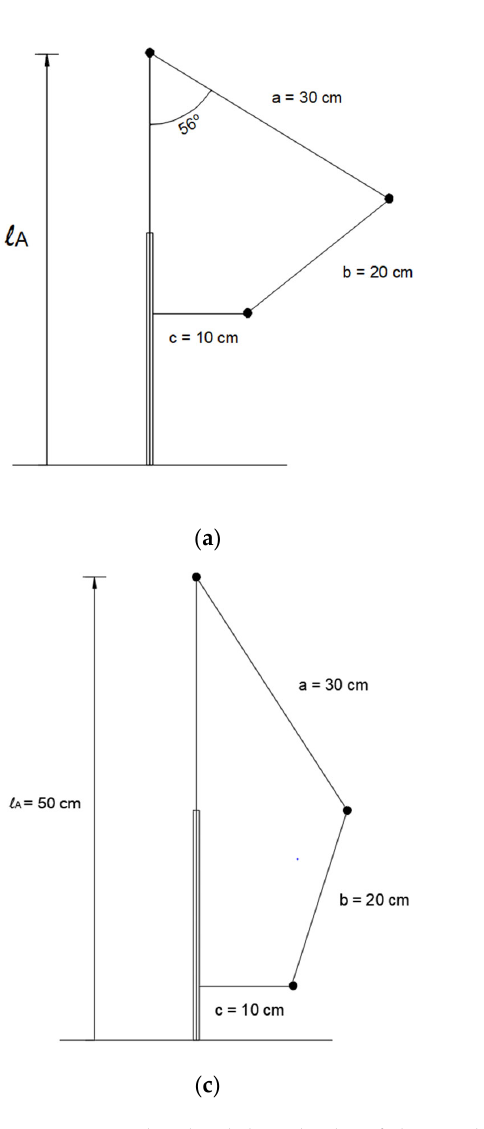
Figure 6. Graphical validity checks of the combinations of mechanical design variables for the proposed heliostat: ( a ) the represented combination meets the condition of positioning at the summer solstice; ( b ) the represented combination meets the condition of positioning at the winter solstice; ( c ) the represented combination does not meet the condition of positioning at the summer solstice; ( d ) the represented combination does not meet the condition of positioning at the winter